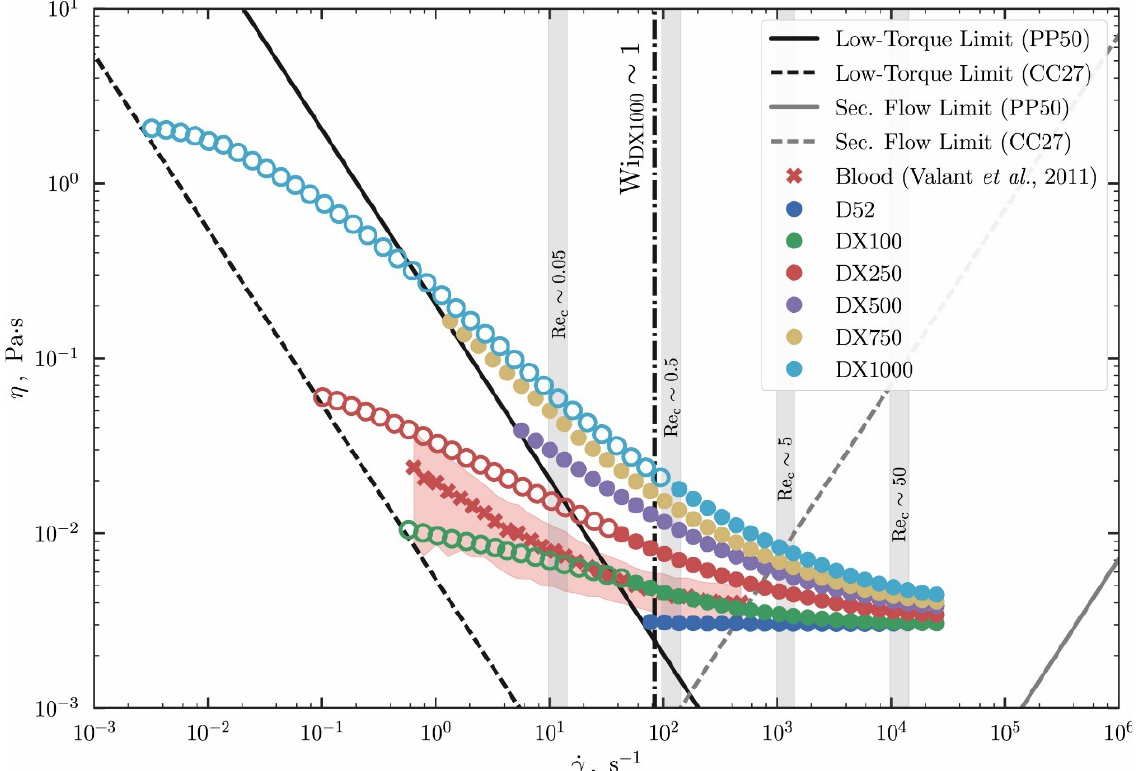
Figure 2. Viscosity curve of the XG solutions in water without the addition of magnetic particles. Reprinted from Journal of non-Newtonian Fluid Mechanics, 286, Rodrigues et al., Haemodynamics around confined microscopic cylinders, 104406, Copyright (2020), with permission from Elsevier. In this graph D52 is the Newtonian blood analogue (XG0 in the present manuscript). The addition of different concentrations of XG are referred to as DX100, DX250, DX500, DX750 and DX1000.